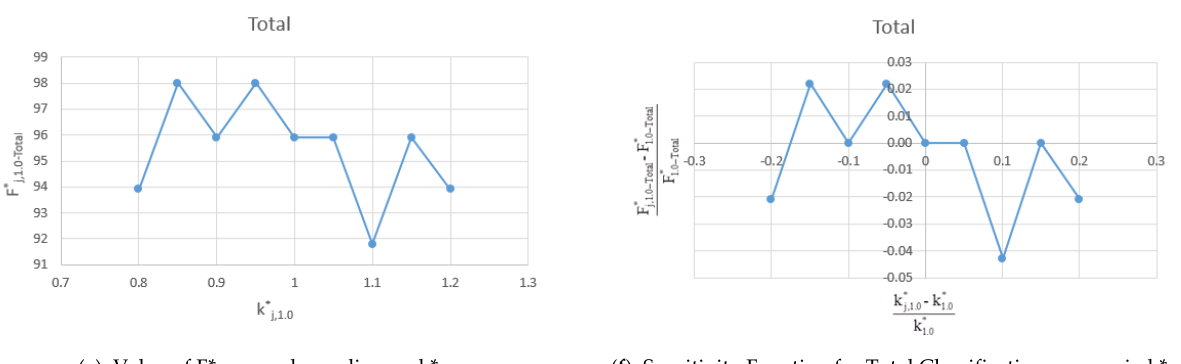
Figure 10. Value of F* j,1.0-Train , F* j,1.0-Test, and F* j,1.0-Total and sensitivity function for the scenario with k* 1.0 . By assuming k* 1.0 the values of each F* j,1.0 (Train, Test, Total) are also good. The F* j,1.0 values are higher than 94.6% for Train, 83.3% for Test, and 91.8% for Total. This is in agreement with the k* 0.3 case and confirms the goodness of both the results and the model accuracy. because the sensitivity function is always lower than 10% and, in the case of Train and Total, are below 5%.